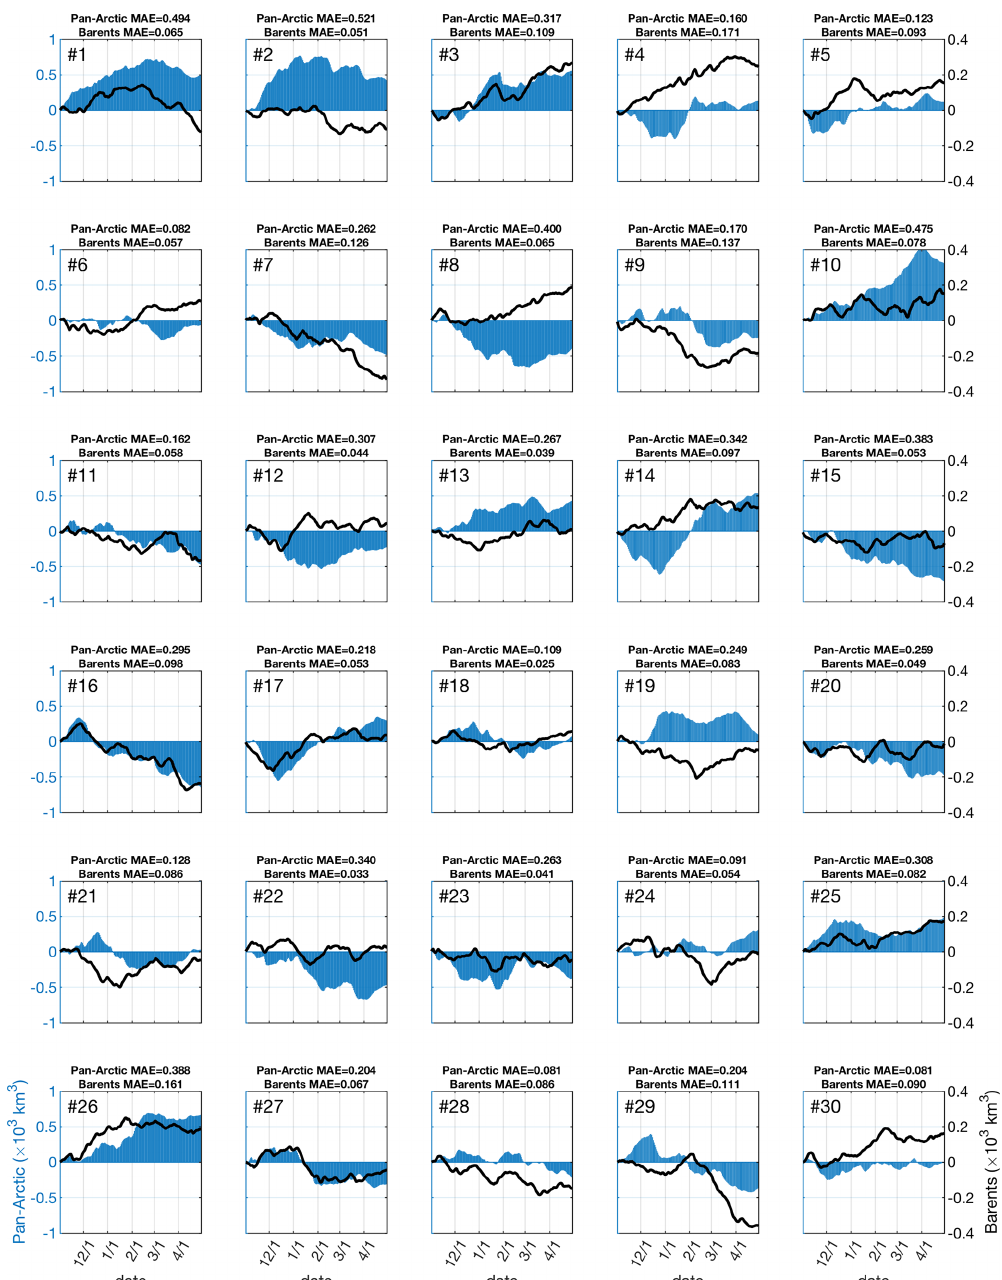
Figure 13. Temporal evolution of the simulated mean absolute difference in sea ice volume (in 10 3 km 3 ) from the ensemble mean for 30 ensemble members of RASM integrations from 1 November 2010 until 30 April 2020 in forecast mode for the pan-Arctic domain (blue) and the BS domain (black lines). Note the different y -axis scales used for the pan-Arctic (left) and BS (right) domains in the